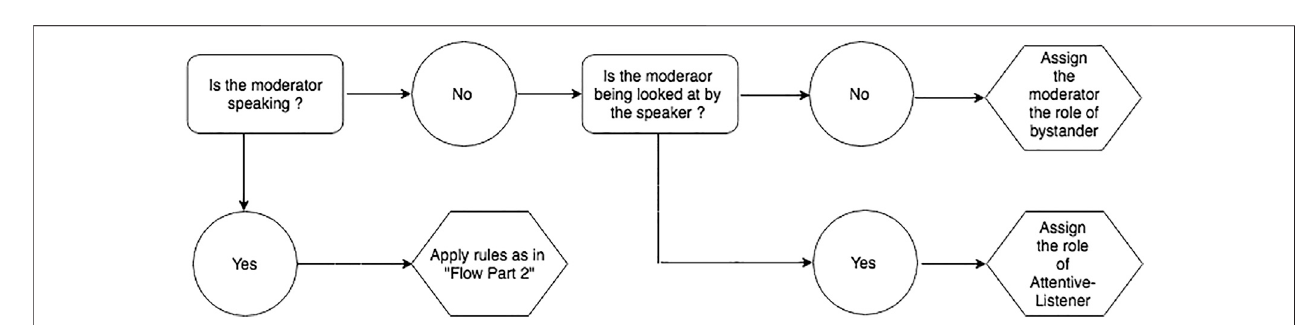
FIGURE 6 | Rules for assigning listener categories: Moderator